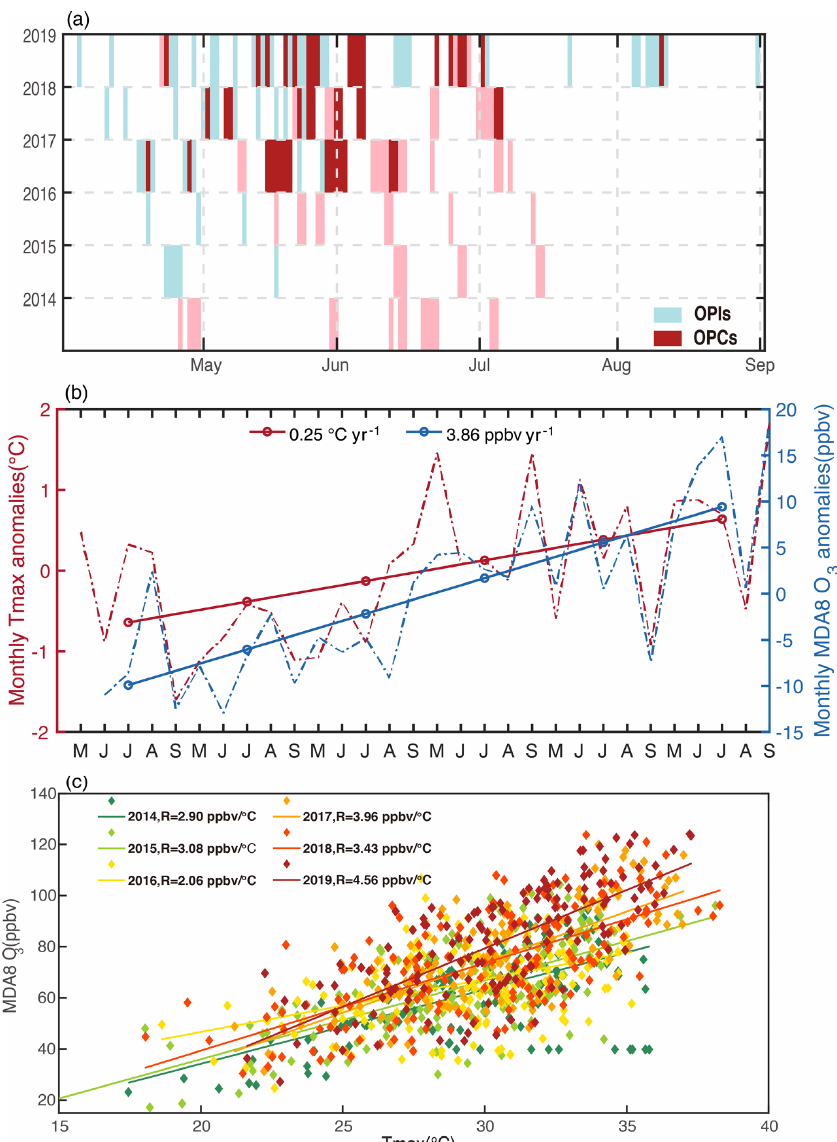
Figure 2. (a) Observed daily variations of the occurrence of OPIs (blue) and OPCs (red) in NCP during 2014–2019. The pink boxes indicate hot days when daily Tmax exceeds its threshold while MDA8 O 3 does not exceed its threshold. (b) Monthly mean MDA8 O 3 (dashed blue line) and Tmax (dashed magenta line) anomalies during May to September of 2014–2019 for the NCP region. For each month, anomalies are computed relative to the 2014–2019 means for that month of the year. The linear trends of the 5-month averaged MDA8 O 3 and Tmax anomalies for each year is shown by the solid lines, with the regression slopes shown near the top of the panel. (c) Scatterplot of daily MDA8 O 3 versus Tmax over NCP for May to September of each year identified by the color in 2014–2019. Linear regression lines and the slope ( R ) values (unit: ppb per degree) are shown for each year, indicating a general trend of increasing R from 2014 to